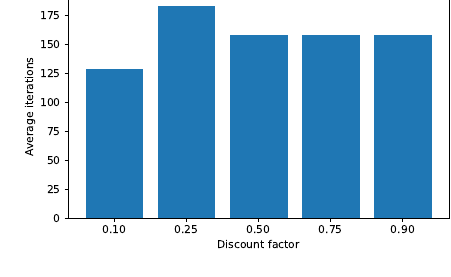
Figure 4. Results with different values for γ